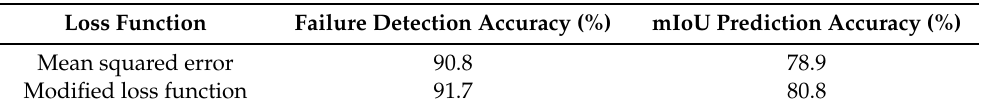
Table 13. Failure detection and mIoU prediction accuracy for the different loss function for the Cityscape dataset with DeepLabV3+.